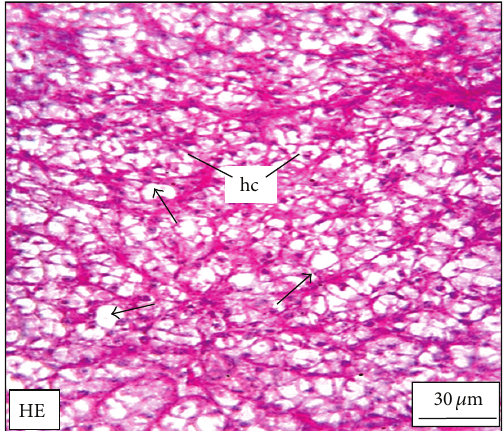
Figure 5: The histological section of the liver of a M. tengara during the early spawning phase (June) depicting comparatively fewer numbers of fat vacuoles (small black arrows) and slight decrease in the size of the hepatocytes (hc) under experimental condition when the tissues are treated with ZnS nanoparticles at the concentration of 250 𝜇 g/L [HE: Haematoxylin-Eosin stain].